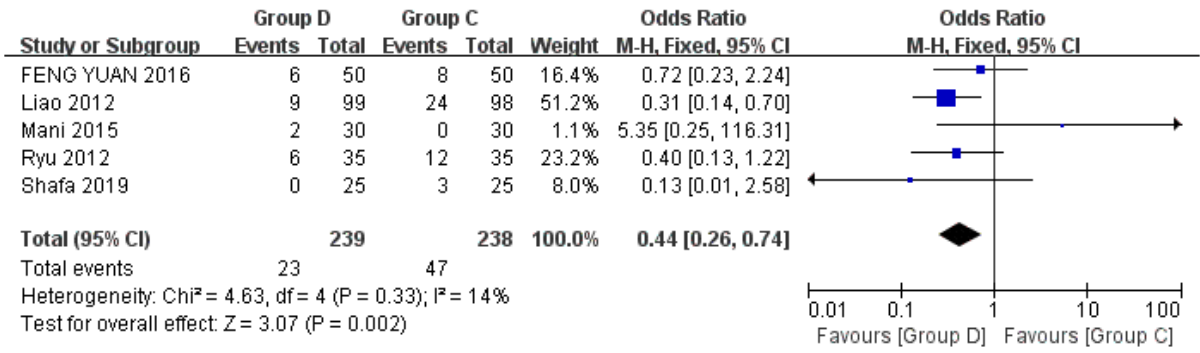
Figure 7. Forest plots comparing the effects of dexmedetomidine and control group on tachycardia [22,24,27,29,32].